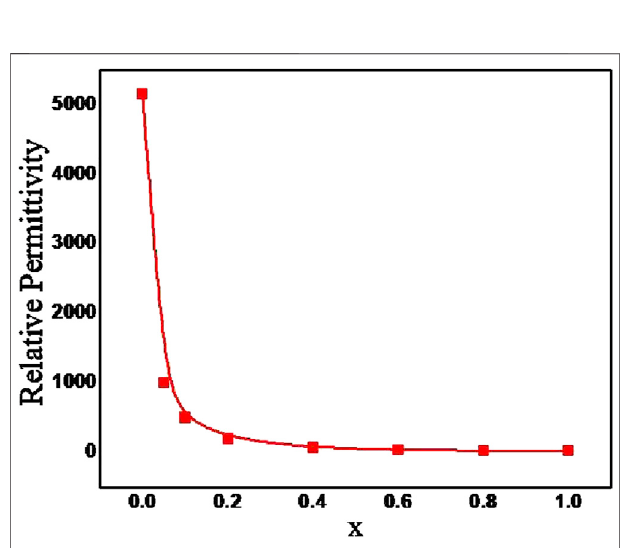
FIGURE 2 | SEM images of BaZr 0.2 [Ti (1-x) Mg x/3 Ta 2x/3 ] 0.8 O 3 solid solution: (A) x (cid:1) 0.0, (B) x (cid:1) 0.1, (C) x (cid:1) 0.4, (D) x (cid:1) 0.6.